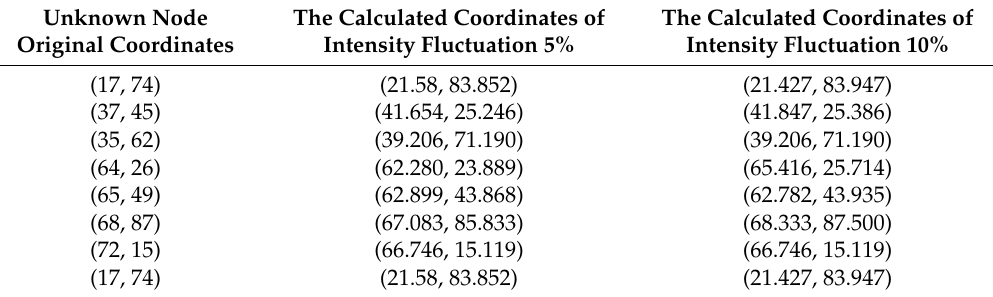
Table 6. Localization results ( n =